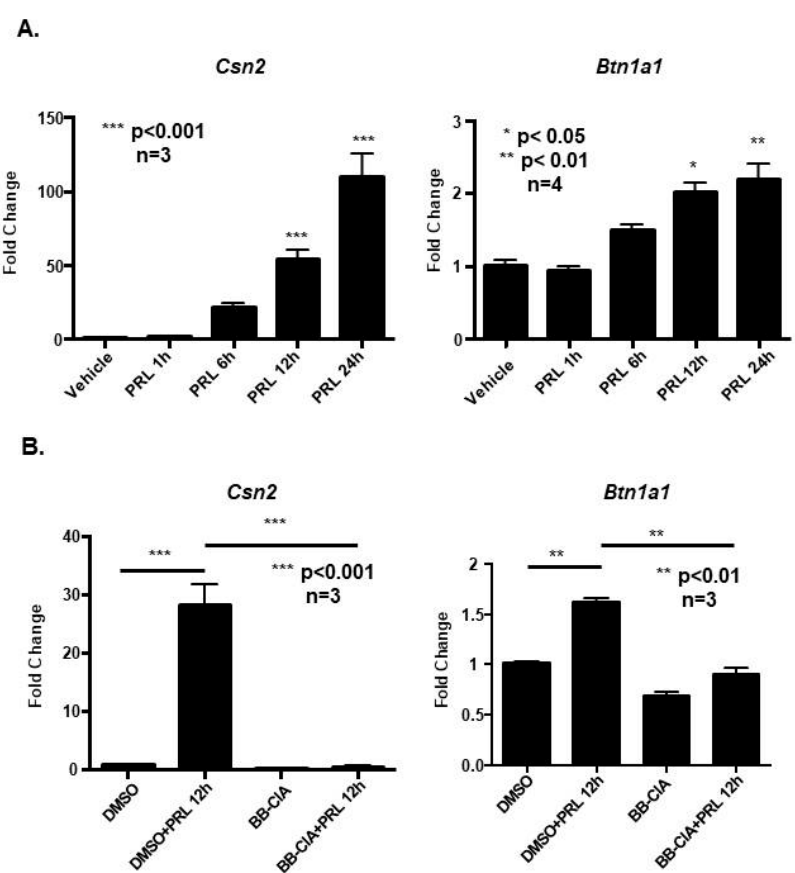
Figure 4. Inhibiting citrullination blocked prolactin induced expression of milk proteins β -casein and butyrophilin in mouse mammary epithelial CID-9 cells. ( A ) CID-9 cells were treated with vehicle or 5 µg/mL prolactin for 1, 6, 12, or 24 h. Total RNA was extracted, reverse transcribed, and subjected to qPCR performed with primers specific to Csn2 and Btn1a1 or Gapdh as the endogenous controls ( n <